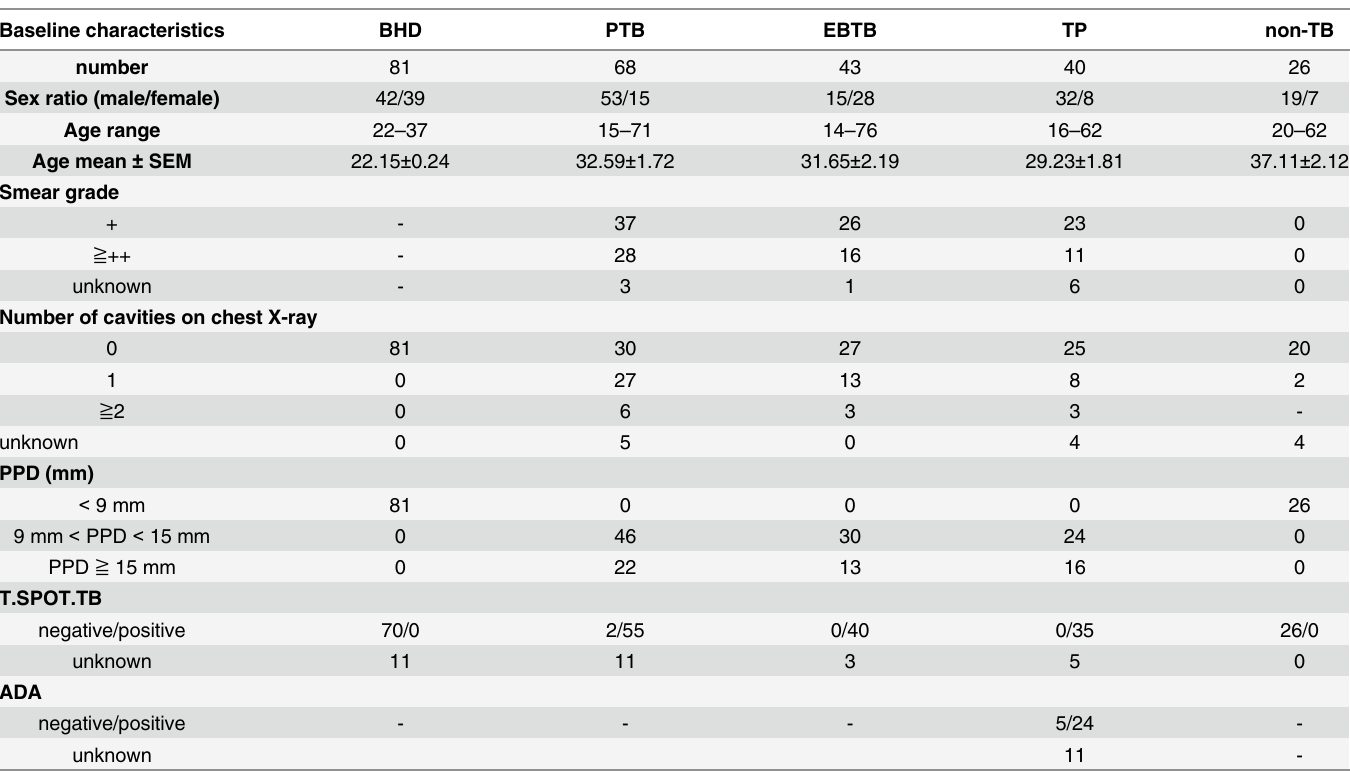
Table 2. Patient